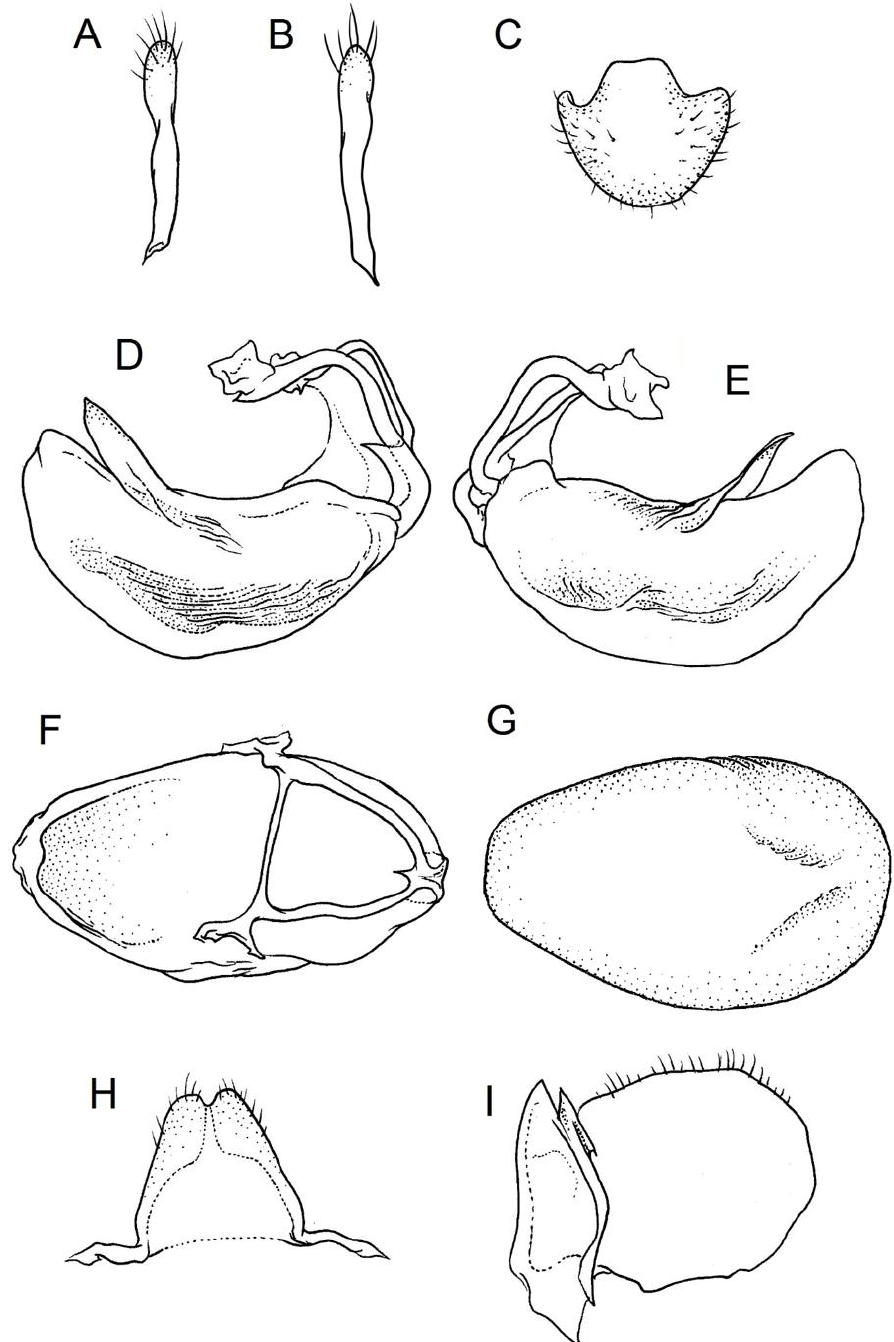
Figure 55. Phonoctonus picturatus Fairmaire, 1858: ( A ) left paramere; ( B ) right paramere; ( C ) pygophore, ventral view; ( D ) aedeagus, right lateral view; ( E ) aedeagus, left lateral view; ( F ) aedeagus, dorsal view; ( G ) aedeagus, ventral view; ( H ) styloids, outer view; and ( I ) gonocoxite of abdominal segment VIII.